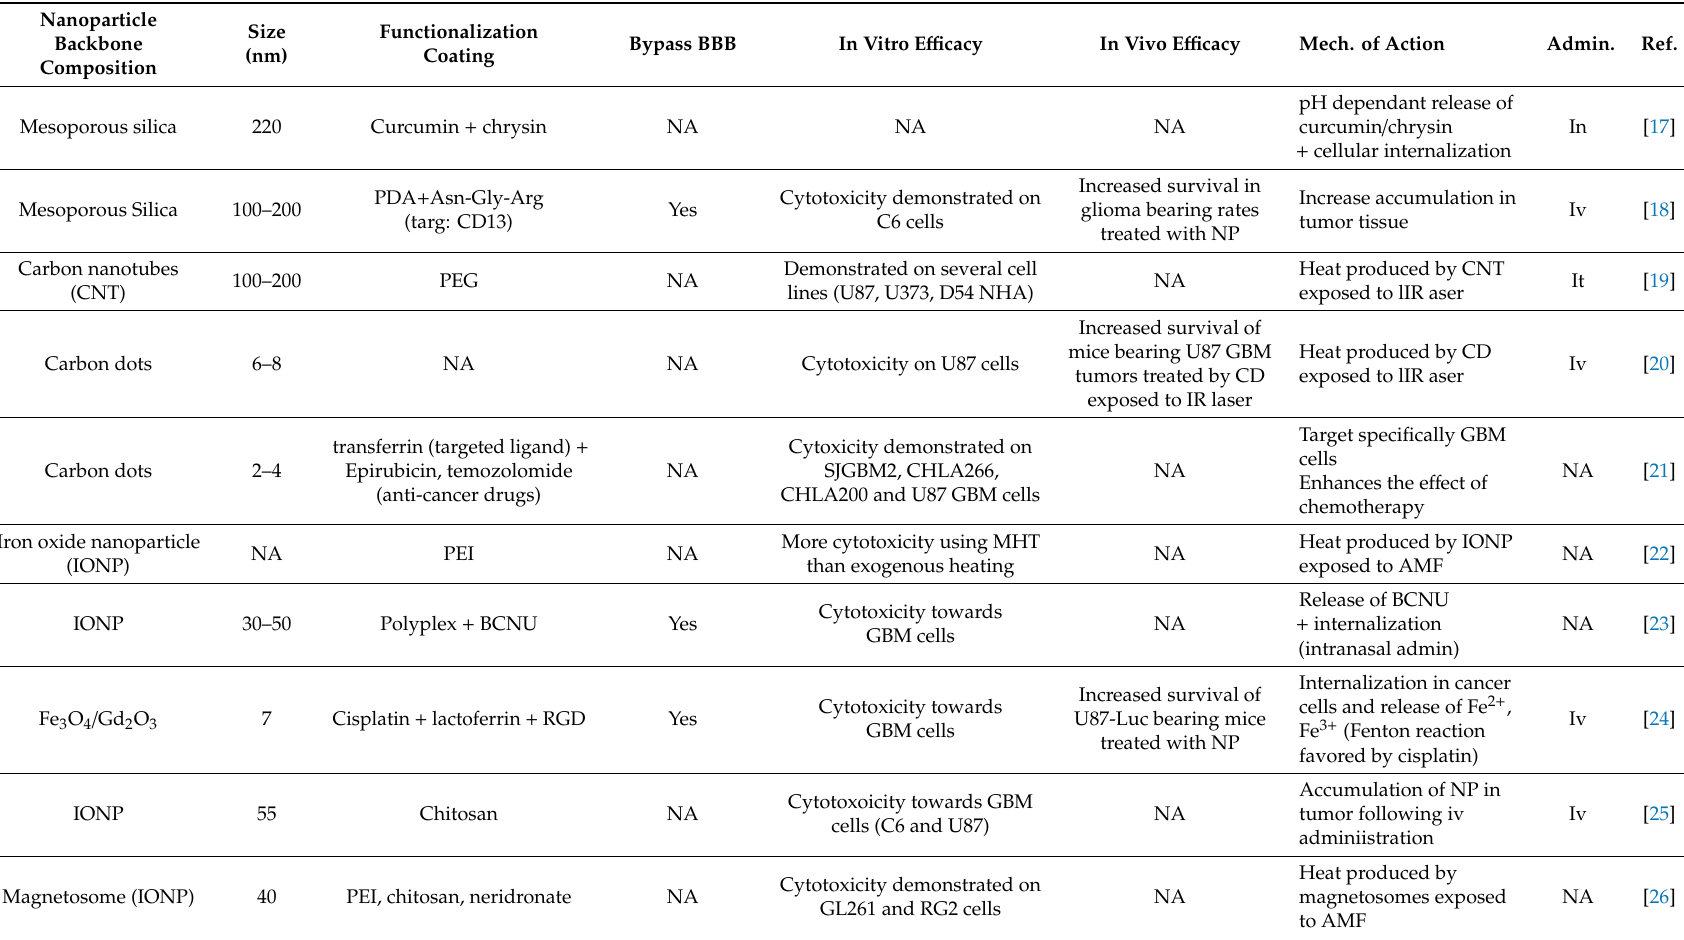
Table 1. A summary of in vitro / in vivo anti-glioblastoma multiforme (GBM) activities reported in the literature for various nano-drugs with di ff erent compositions, abilities to bypass (or not) the blood brain barrier (BBB), and mechanisms of actions. NA: not available. Iv: intravenous. It: intratumoral. In: intranasal; IONP: